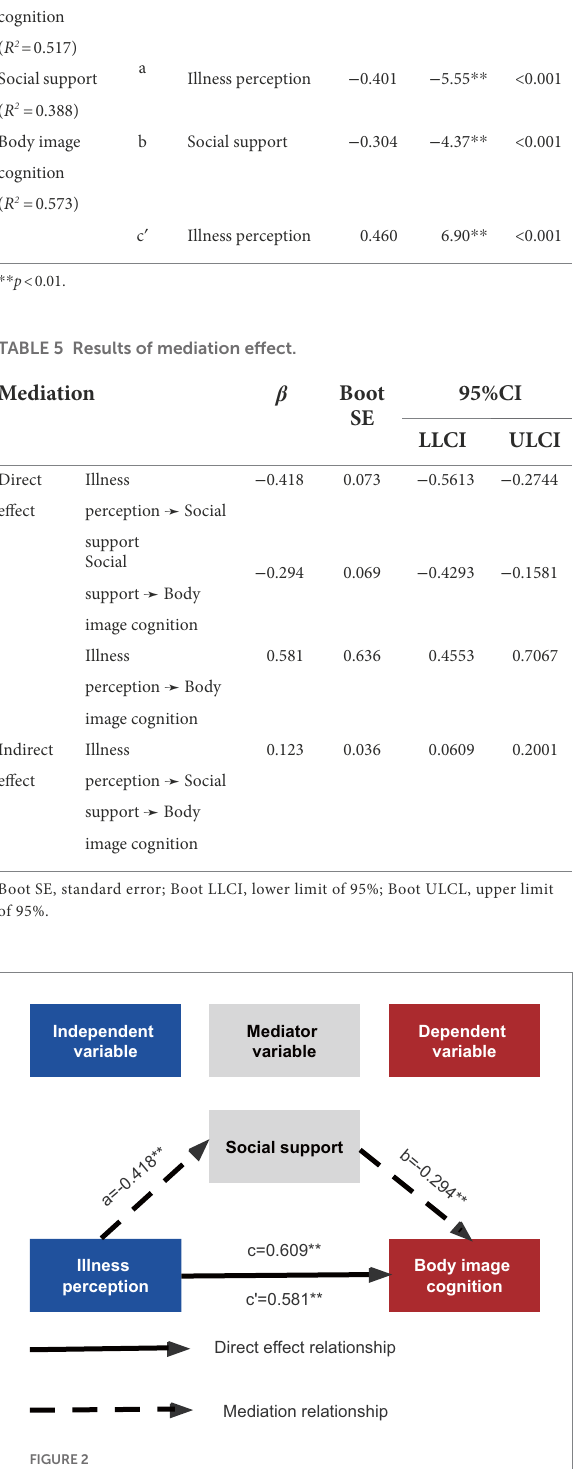
TABLE 4 Regressions of illness perception, social support and body image cognition. Dependent variable